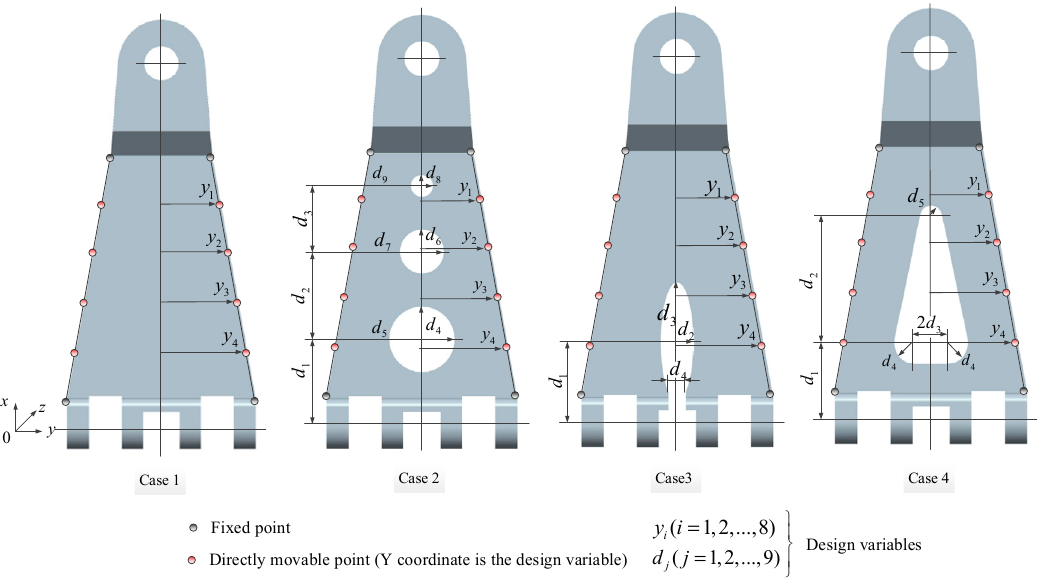
Figure 8. Four topological configurations and related design variables.